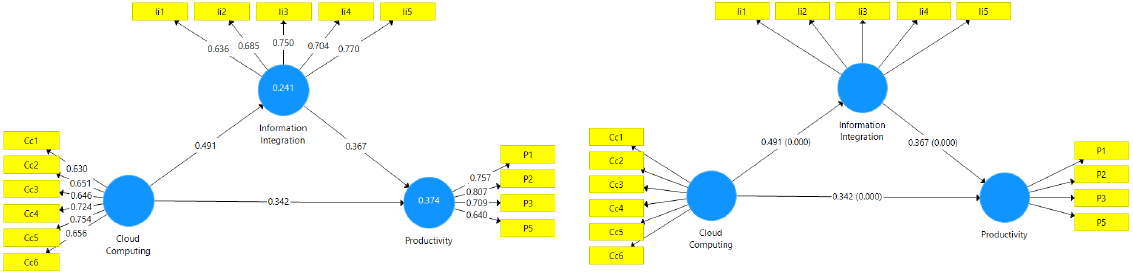
Fig. 2. Outer Loadings Fig. 3. Measurement model with T, P values